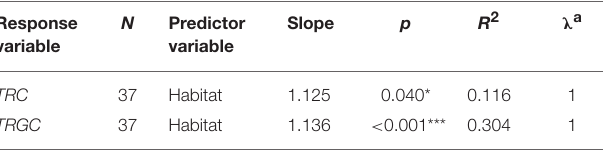
TABLE 2-1 | Significant results of PGLS regression for TRC gene numbers vs. ecological factors. Response variable